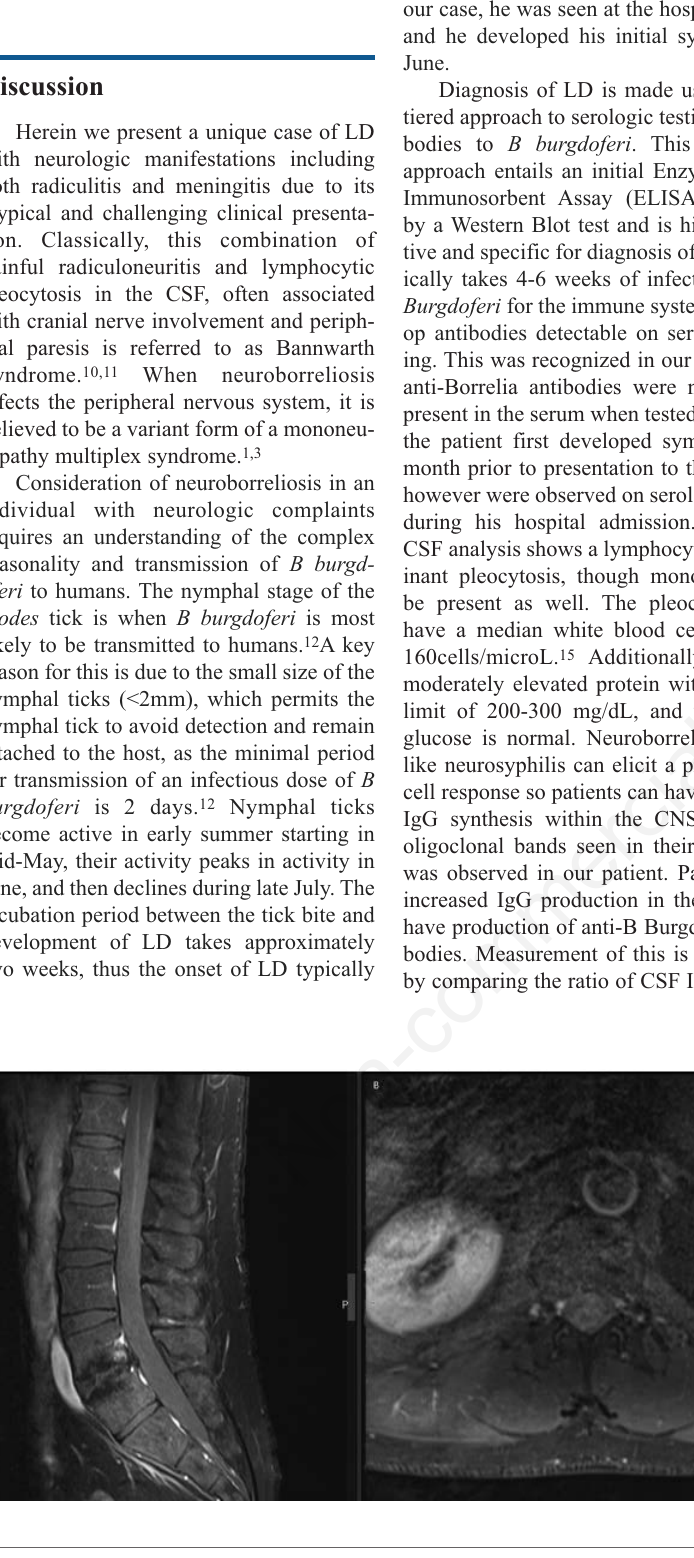
Figure 1. A) T1 Post-Contrast Saggital view showing slightly thickened enhancement along the surface of the conus medullaris as well as enhancement of the nerve roots of the cauda equina. B) T1-Post-Contrast Axial view showing slightly thickened enhance- ment along the surface of the conus medullaris as well as enhancement of the nerve roots of the cauda